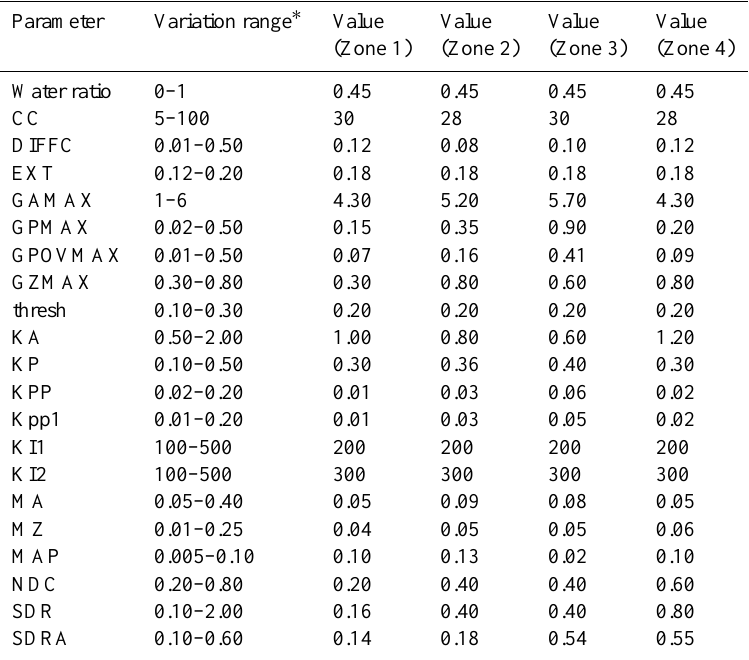
Table 5. Calibrated parameter values.